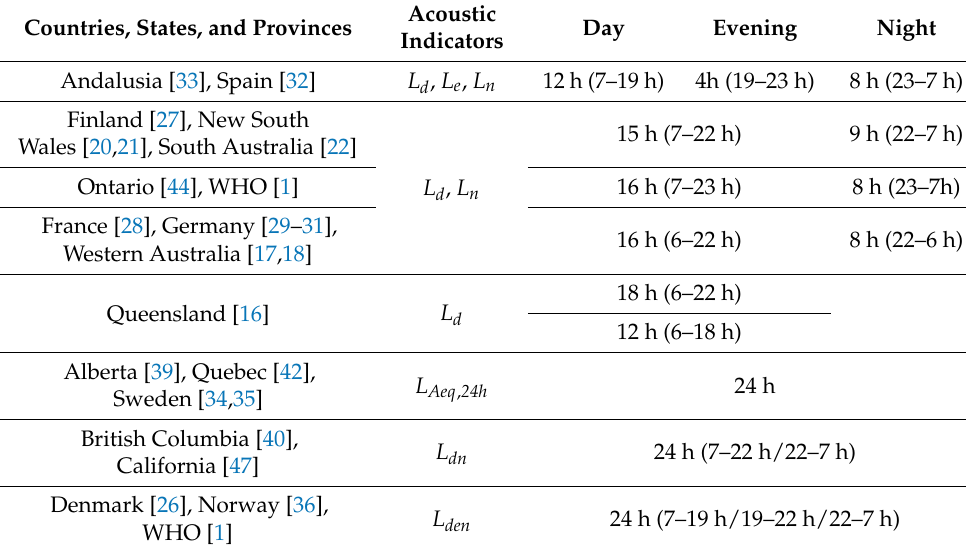
Table 6. Day, evening, and nighttime measurement periods for each geographic area. The shaded boxes represent the measurement periods not compatible with Brink’s method (see Section